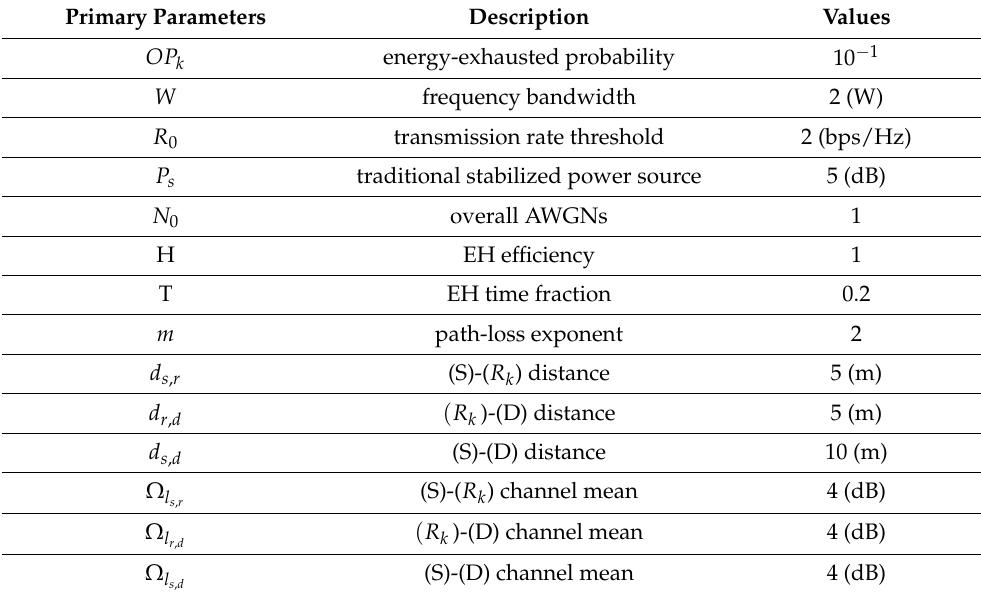
Table 1. Simulation